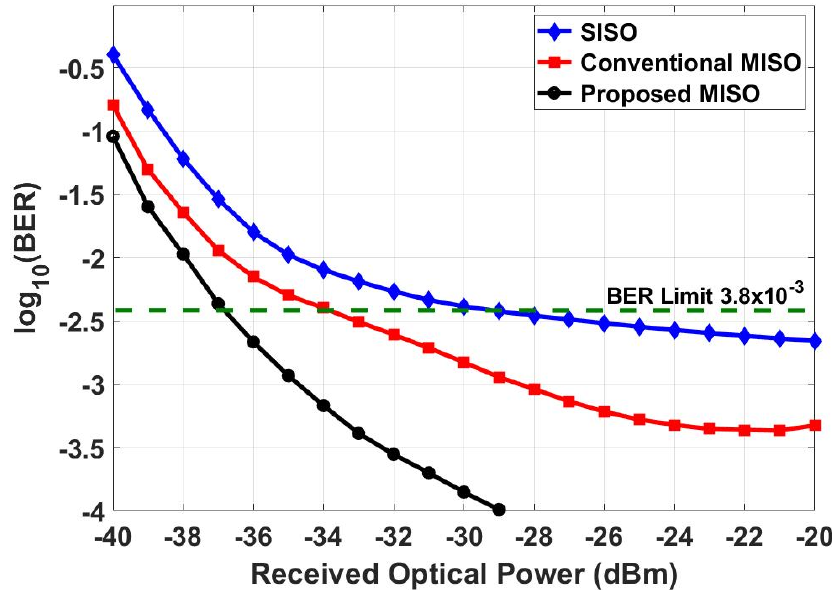
Figure 10. BER performance using SISO and 4 × 1 MISO processing with the conventional and proposed optimum receiver against the received optical power for a fixed transmission distance of 6 m.